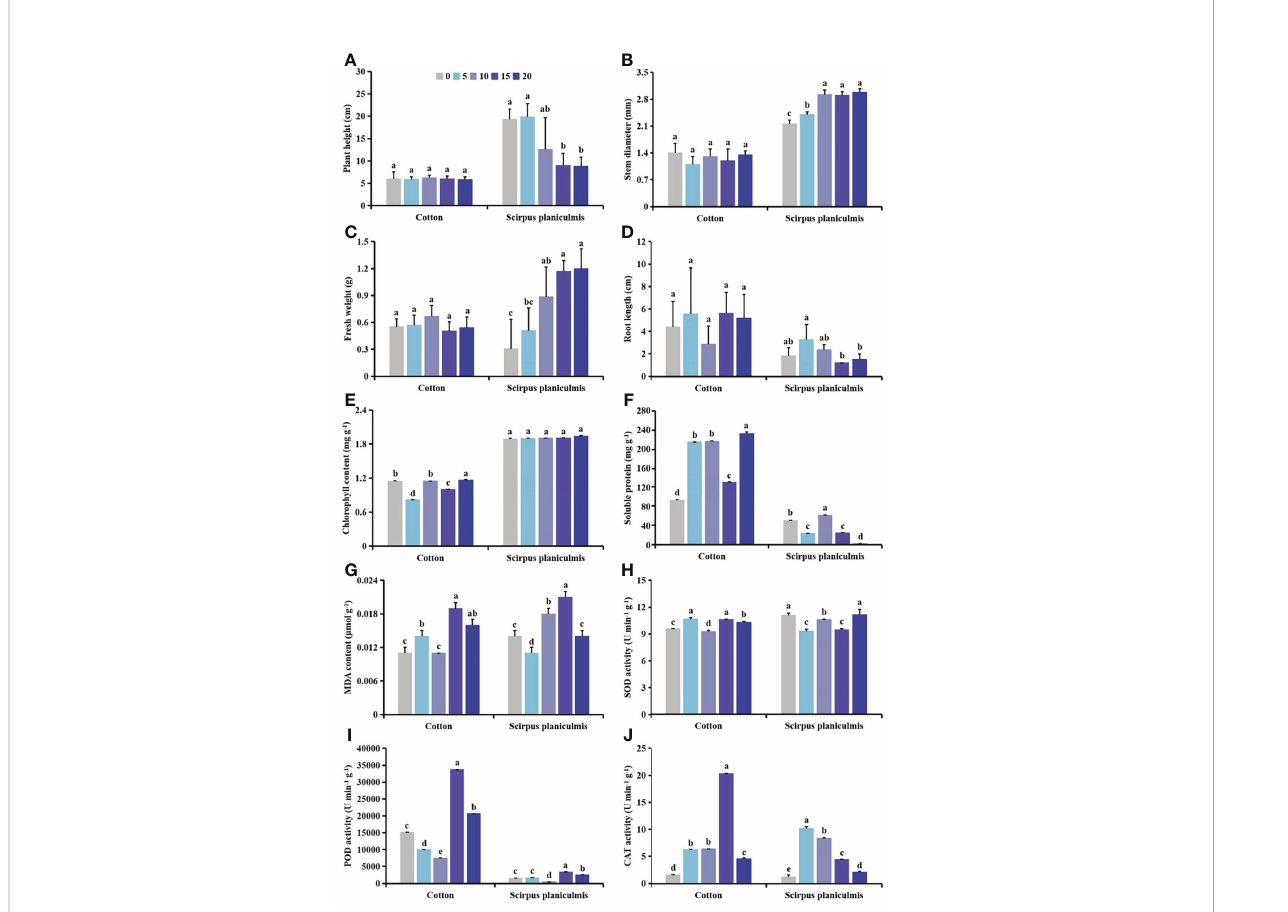
FIGURE 9 The (A) plant height, (B) stem diameter, (C) fresh weight, (D) root length, (E) chlorophyll, (F) soluble protein and (G) malondialdehyde (MDA) content, and (H) superoxide dismutase (SOD), (I) peroxidase (POD) and (J) catalase (CAT) activities in cotton and S. planiculmis with different spatial distribution of Scirpus planiculmis . The mean value ± standard data were presented in the fi gure. Different alphabetical letters indicate the signi fi cant differences between different distances ( p